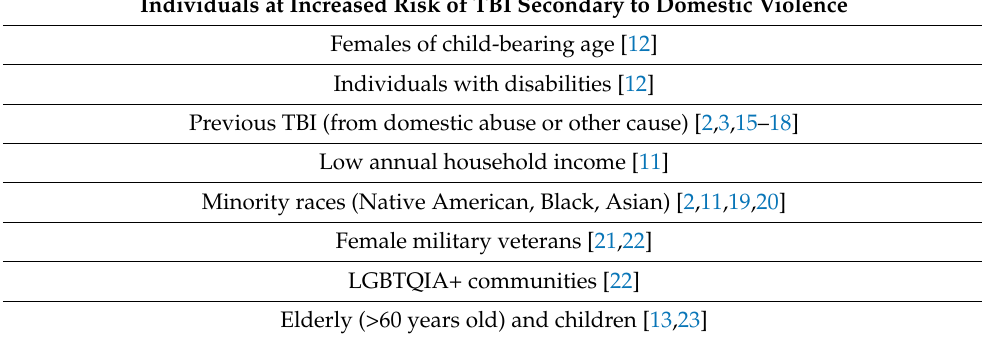
Table 1. Risk factors for TBI secondary to domestic